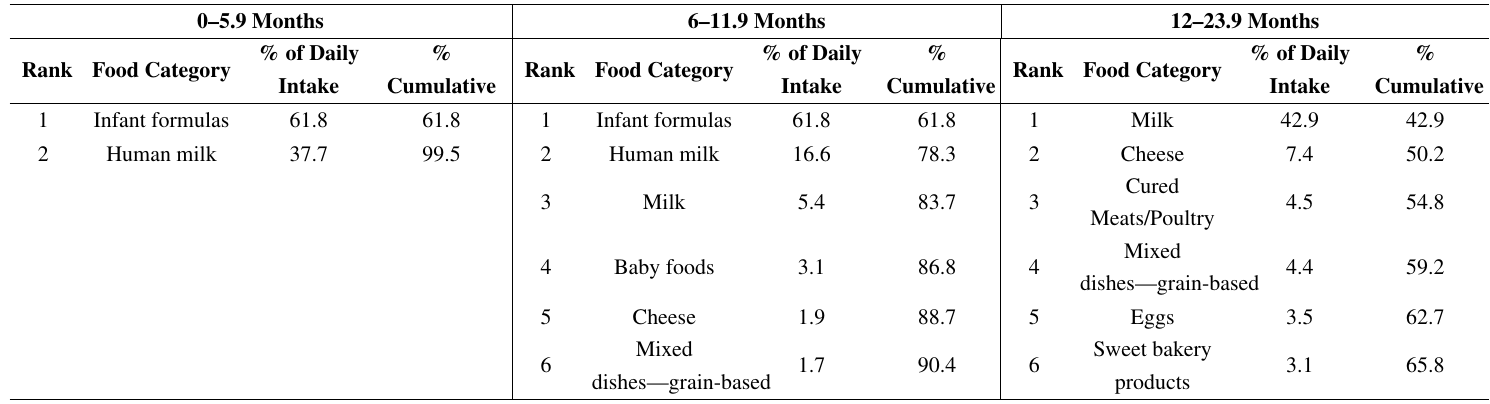
Table 5. Food sources of saturated fat among US infants and toddlers aged 0–23.9 months by age group: NHANES 2005–2012 ( n = 2740) a